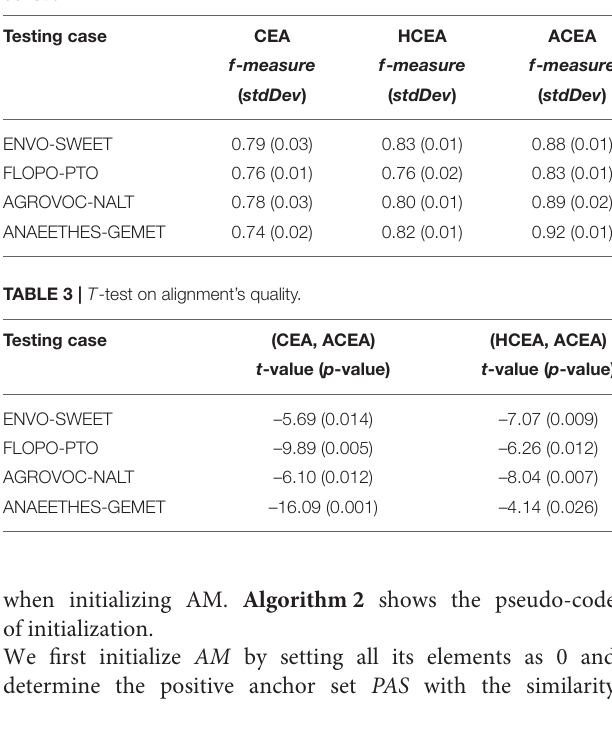
TABLE 2 | Comparisons among Adaptive Compact EA (ACEA), Compact EA (CEA), and Hybrid CEA (HCEA) in terms of mean f-measure and standard deviation.